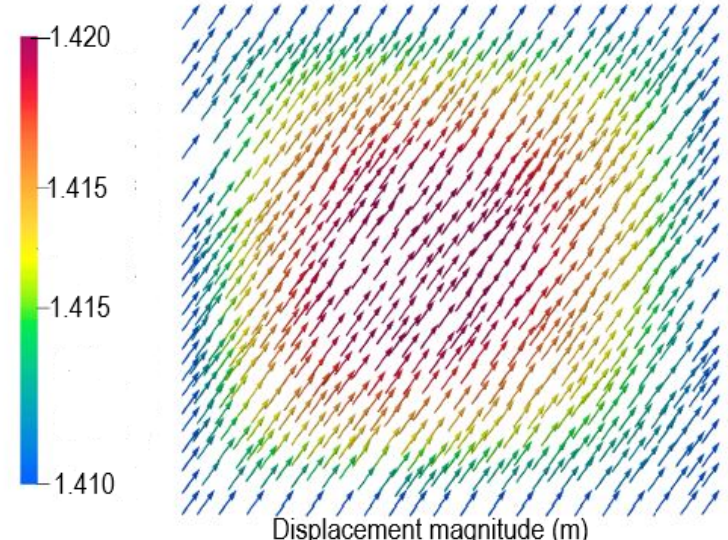
Figure 6. Computed displacement field from CSMP++.